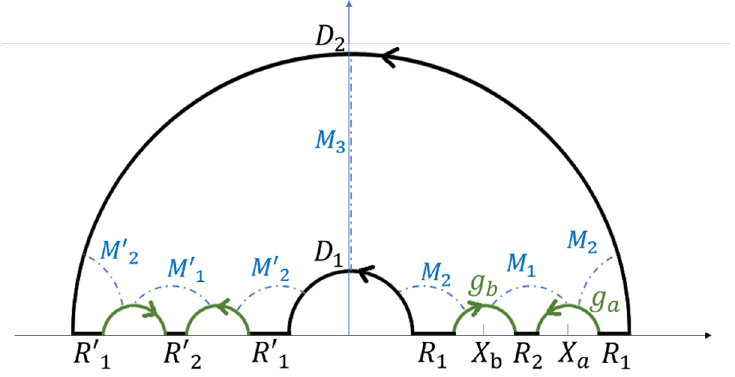
Figure 25 . A fundamental region of the quotient space of the 4-side wormhole in figure 2. It is symmetric with respect to the horizon M 3 . The geodesics g a and g b are identified in an orientation- reversed